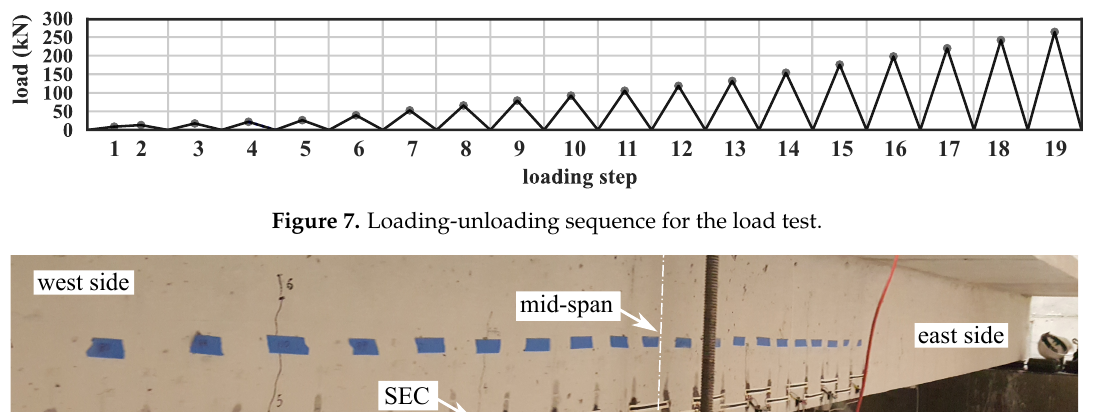
Figure 6. Picture showing the experimental setup of the large-scale post-tension beam test setup.